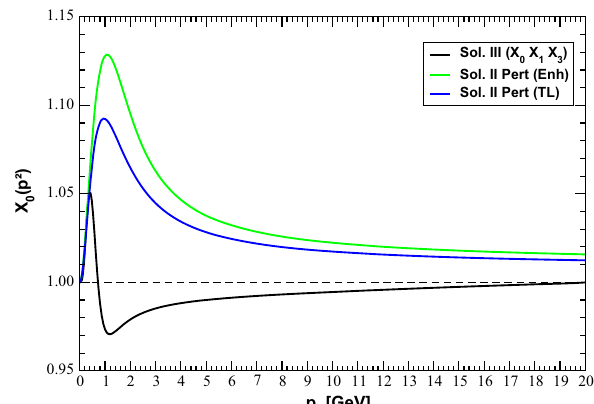
Fig. 29 The quark-ghost kernel form factor Y 3 ( p 2 )